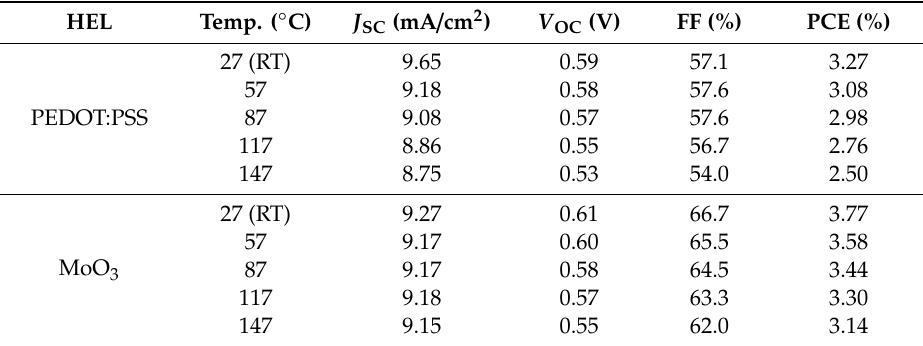
Table 1. Performance parameters of OSCs as a function of operating temperature using PEDOT:PSS and MoO 3 as HEL under 1-sun